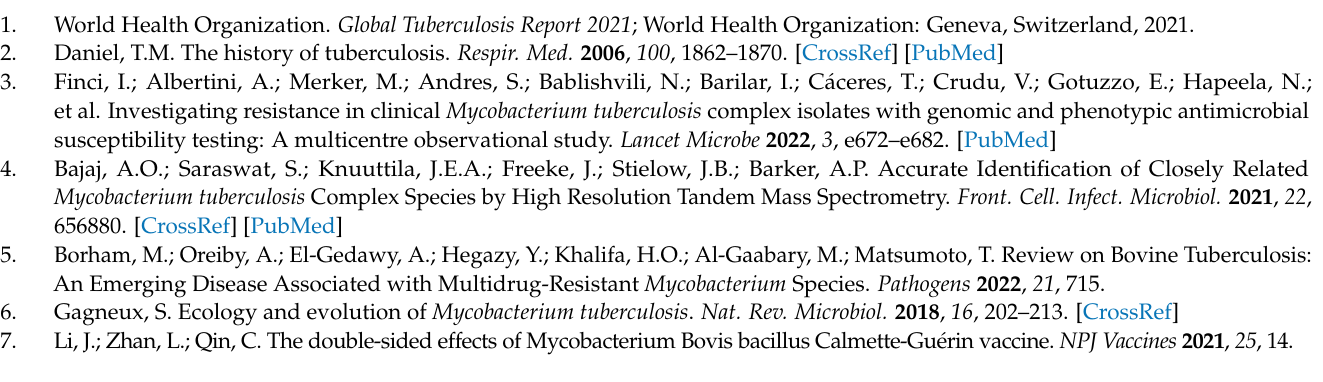
for group two (vaccinated with BCG + betulinic acid); Figure S17: A large number of lymphatic follicles with generative centers in the lung tissue for group two (vaccinated with BCG + betulinic acid); Figure S18: Lymphatic follicle at the branching site of medium-sized bronchi for group three (vaccinated with BCG + betulin); Figure S19: A blood vessel in the area of the lungs compacted as a result of the proliferation of epithelioid macrophages for group three (vaccinated with BCG + betulin); Figure S20: The initial stage of formation of a lymphatic follicle near a blood vessel for group three (vaccinated with BCG + betulin); Figure S21: One of the few follicles with a breeding center for group three (vaccinated with BCG + betulin); Figure S22: Plasma cells (cells with bright pink cytoplasm) among epithelioid macrophages, as well as near a small lymphatic follicle for group three (vaccinated with BCG + betulin); Figure S23: Areas of lung tissue compaction of various sizes for group four (vaccinated with BCG + betulonic acid); Figure S24: A small accumulation of lymphoid cells near a medium-sized bronchus for group four (vaccinated with BCG + betulonic acid); Figure S25: Cellular couplings of a small number of lymphocytes around a blood vessel in the area of proliferation of epithelioid macrophages for group four (vaccinated with BCG + betulonic acid); Figure S26: Plasma cells (cells with bright pink cytoplasm) in the walls of the alveoli for group four (vaccinated with BCG + betulonic acid); Figure S27: The small size follicle without a pronounced reproduction center for group four (vaccinated with BCG + betulonic acid); Figure S28: Accumulation of lymphoid cells near the bronchus and artery for group five (vaccinated with BCG); Figure S29: A small collection of lymphoid cells in the form of a nodule in the peribronchial tissue for group five (vaccinated with BCG); Figure S30: Lymph follicles maintain contact with blood vessels for group five (vaccinated with BCG); Figure S31: A large lymphatic follicle located between the bronchus and the artery for group five (vaccinated with BCG); Figure S32: A few perivascular couplings show no evidence of lymphatic follicle formation for group five (vaccinated with